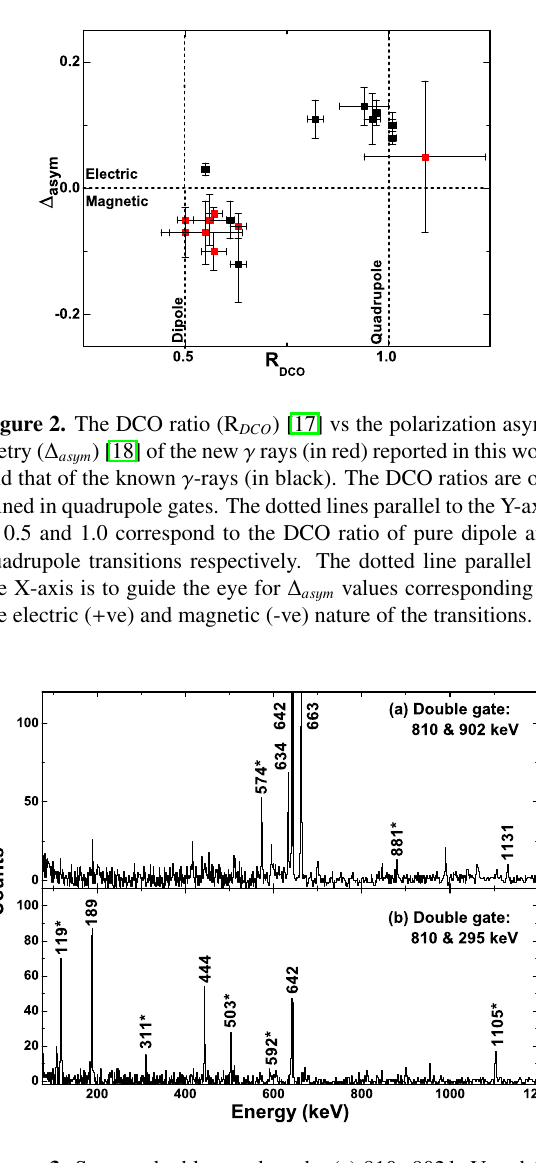
131 Xe, related to the present paper, is shown in Fig. 1. The R DCO vs ∆ as y m plot for the transitions of 131 Xe, reported in this paper are shown in the Fig.